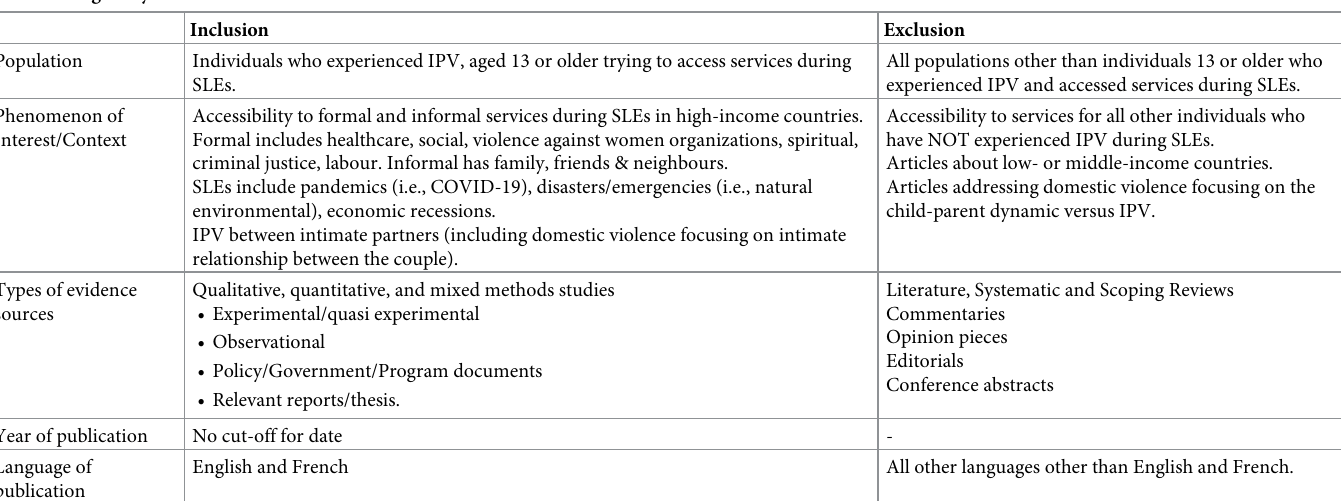
Table 2. Eligibility